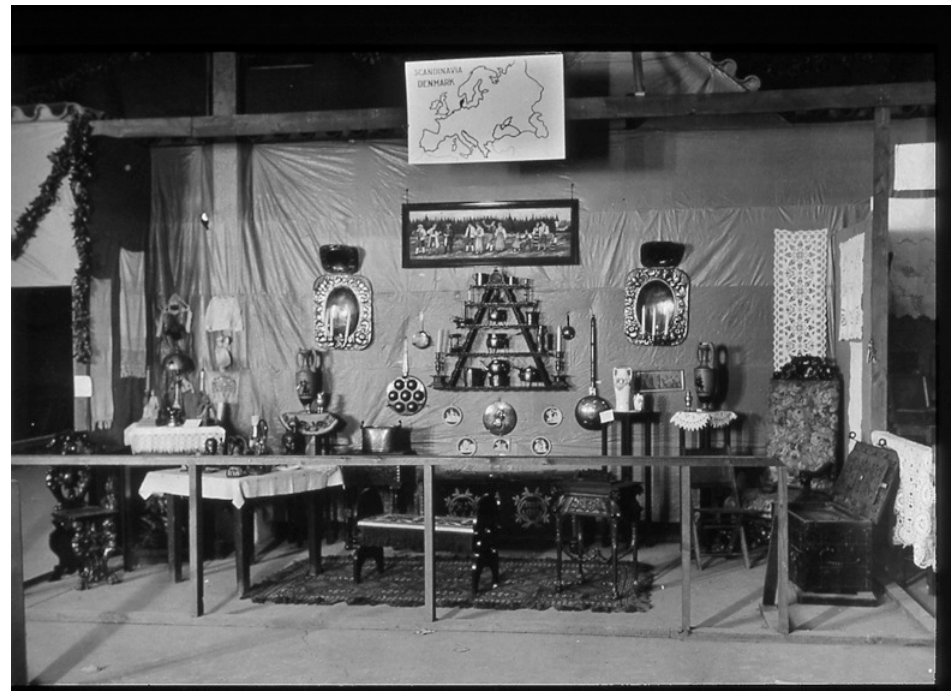
Unknown photographer, Danish booth at the Rochester Arts and Crafts of the Homelands exhibition held April 10-19, 1920 on the grounds of Exposition Park in Rochester, NY. Memorial Art Gallery, University of Rochester